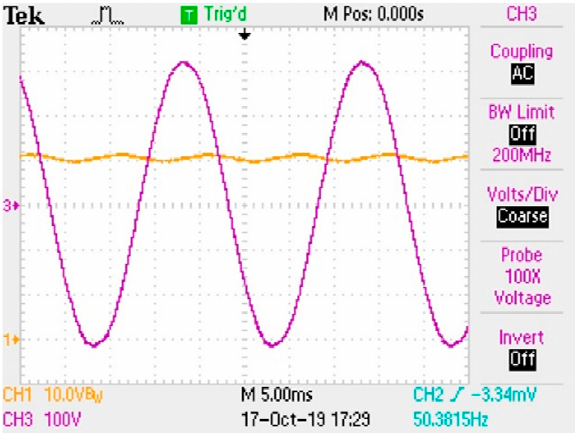
Figure 19. Experimental results of input voltage and DC ‐ bus voltage.